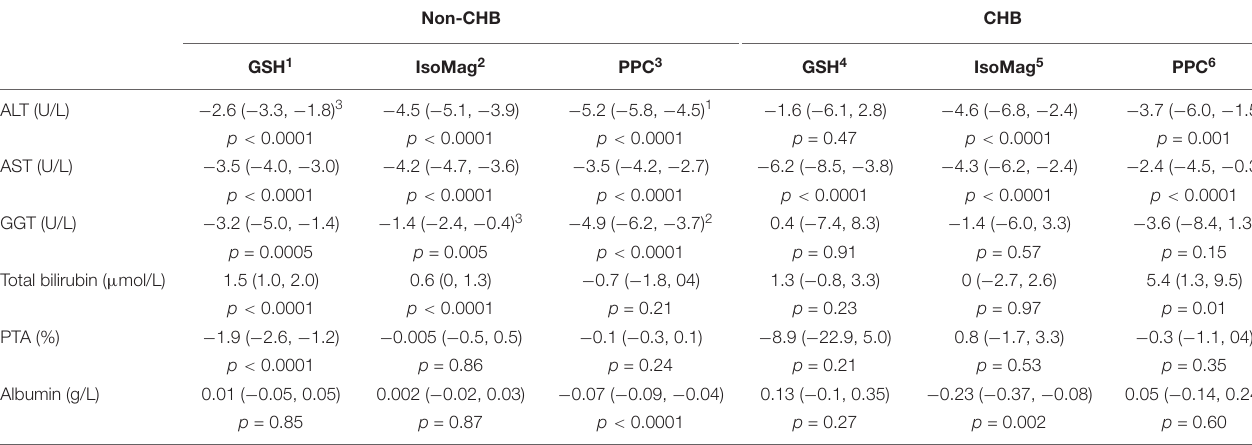
TABLE 4 | Compare slopes of liver function parameters by treatment groups between non-CHB and CHB